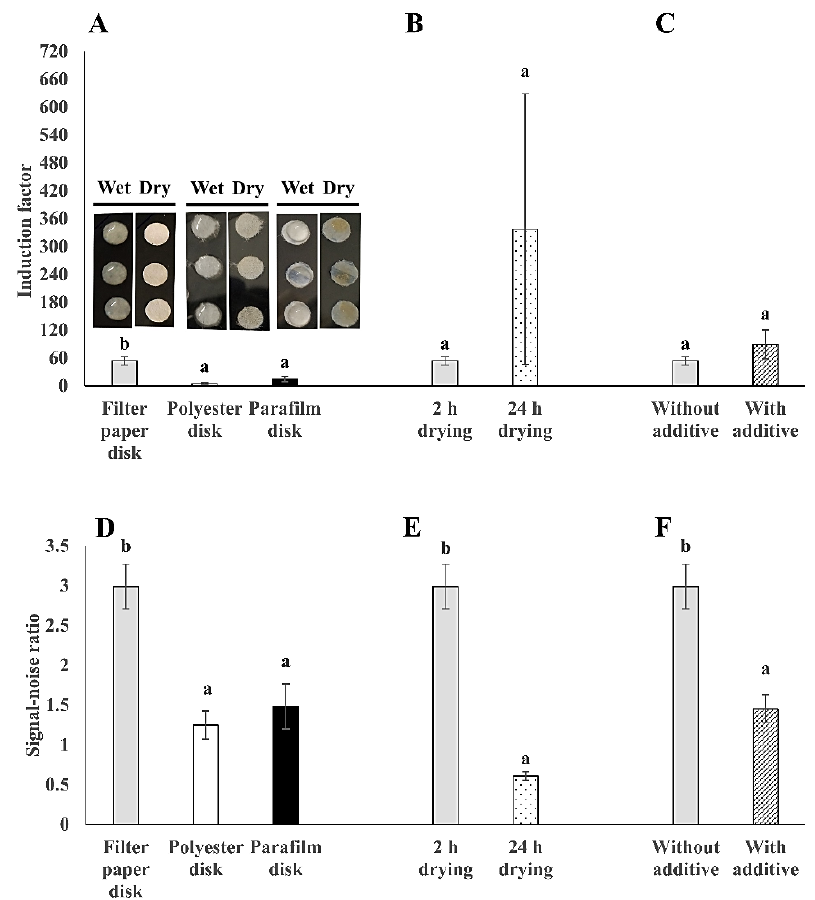
Figure 5. Comparison between di ff erent membrane disks as immobilization matrices. Induction factor values of ( A ) three surface materials: Filter membrane, polyester membrane, and parafilm disks; ( B ) e ff ect of drying time on filter membrane disks; ( C ) e ff ect of additives: 10 mM glucose and 100 µ g / mL ampicillin on filter membrane disks, on the sensitivity of surface-immobilized E. coli bioreporter strain TV1061 to 2% ( v / v ) ethanol; and signal-noise ratio values of ( D ) three surface materials; ( E ) e ff ect of drying time on filter membrane disks; ( F ) e ff ect of additives on filter membrane disks on the sensitivity of immobilized TV1061 to 2% ( v / v ) ethanol. All the values in the graphs are presented as mean ± standard error of the mean (SEM), with di ff erent letters above the bars that indicate significant di ff erences ( p < 0.05), which were tested by the student’s t -test ( B , C , E , F ) and the